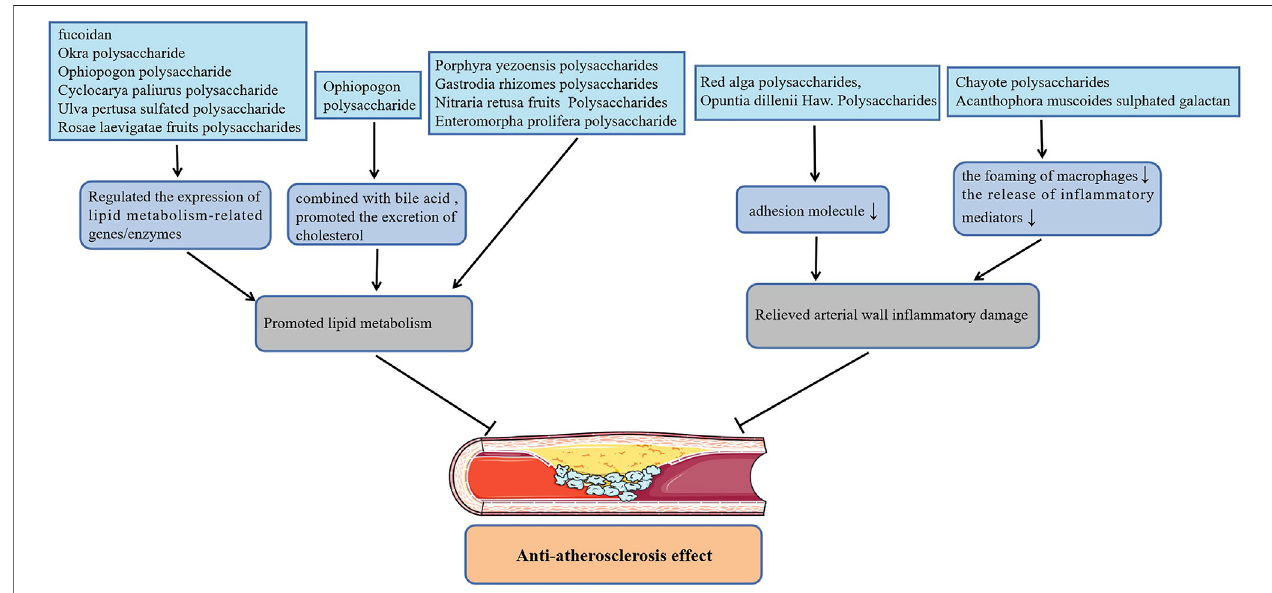
FIGURE 2 | Plant polysaccharides with anti-atherosclerosis